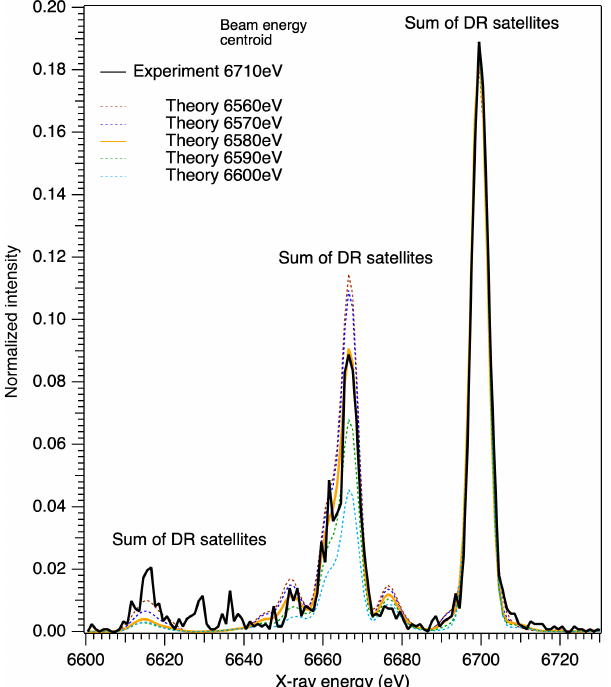
Figure 3. The same as Figure 1 at the nominal experimental beam energy of 6710